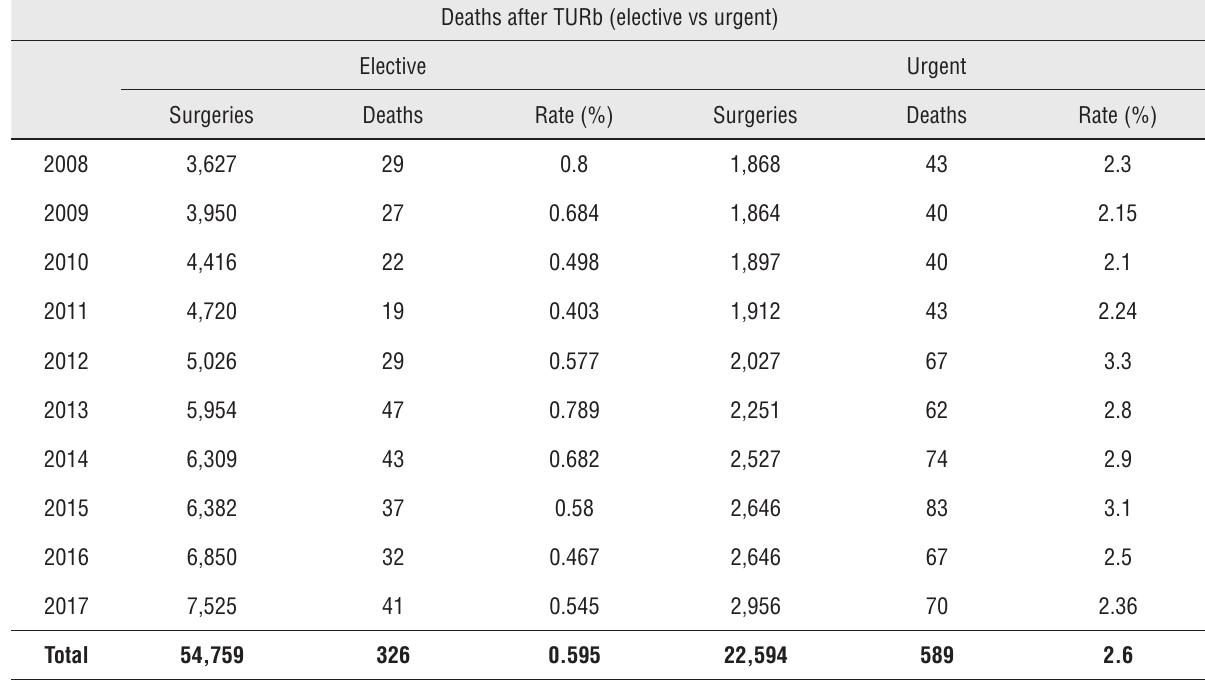
Table 3 - Deaths after TURb, elective vs.